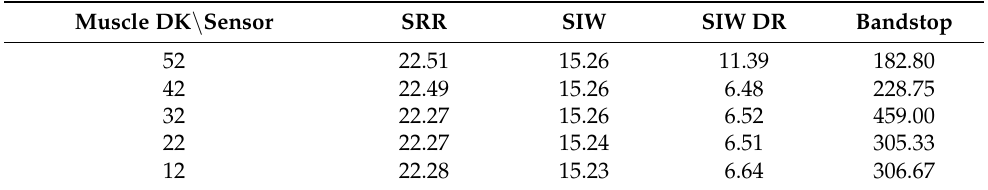
Table 4. Quality factor at 3 dB for the sensors with varying muscle